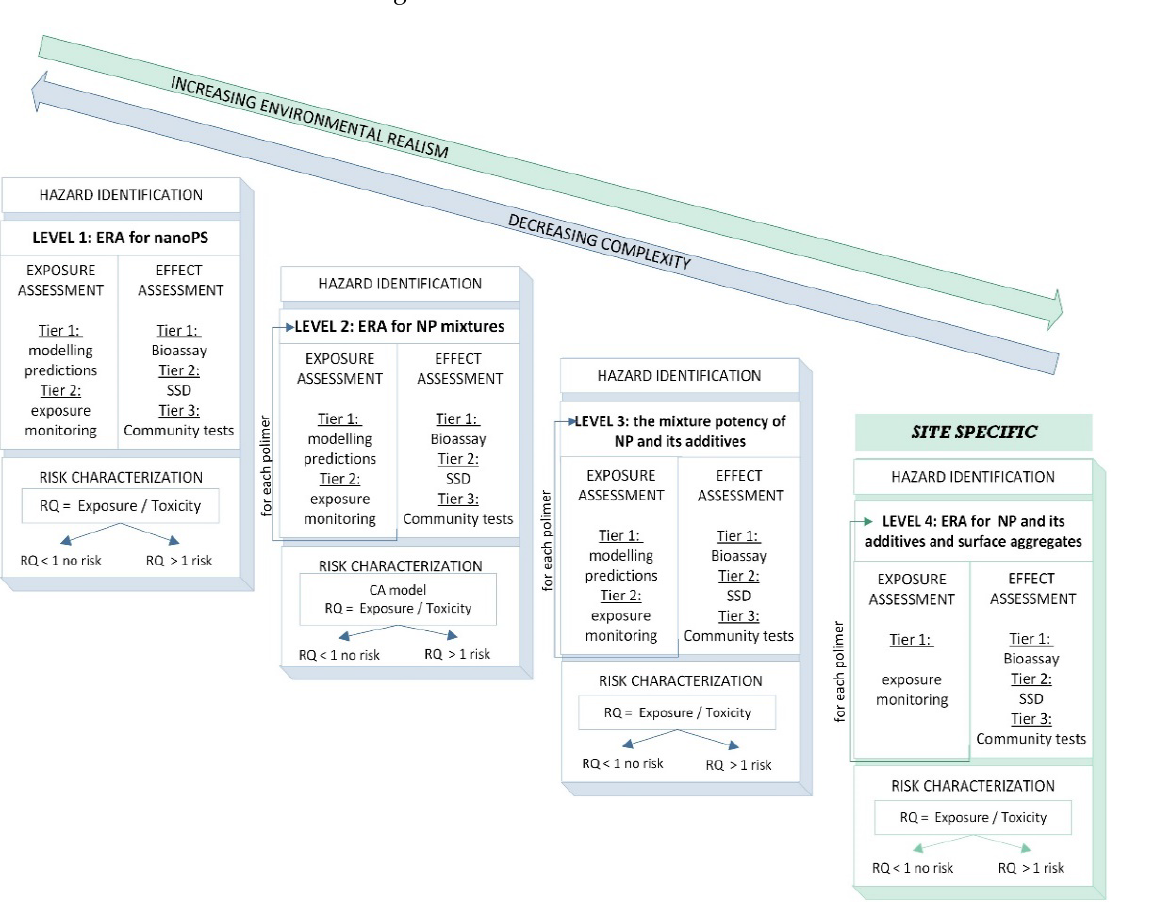
Figure 4. Tools for exposure and effect assessments as part of the general environmental risk assess- ment framework for NPs.